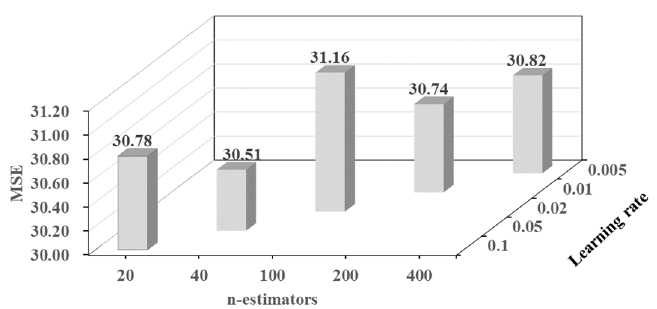
Figure 14. The MSE of the GBRT-M with different n-estimators and learning rate . Figure 13. The MSE of gradient boosting regression tree model(GBRT-M) with different n-estimators . Note: the range of n-estimators is from 10 to 100, and the step length is 10.